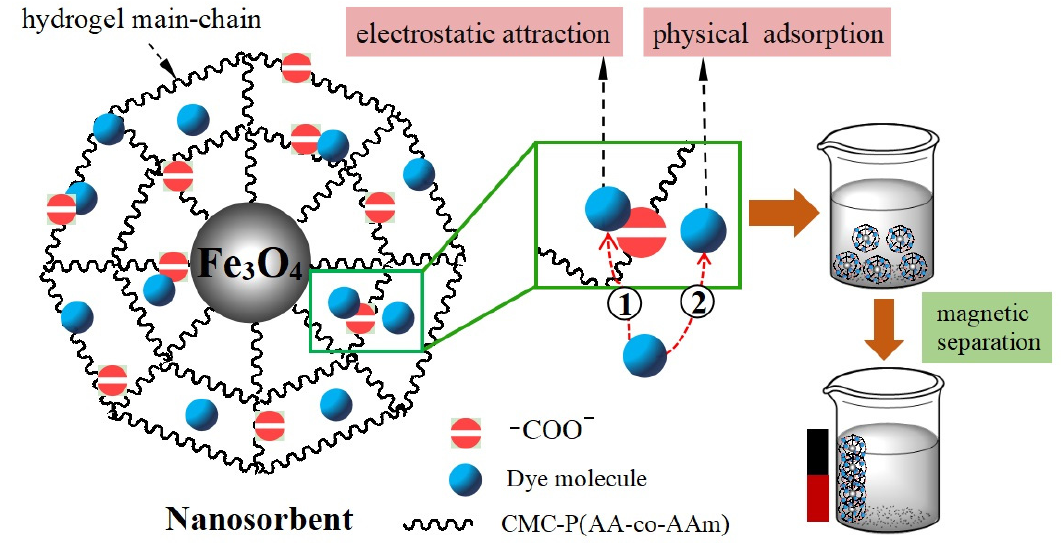
Figure 13. The XPS survey spectra ( a ), curve fitting for O 1s spectra of mag-hydrogel before ( b ) and after ( c ) MB adsorption.